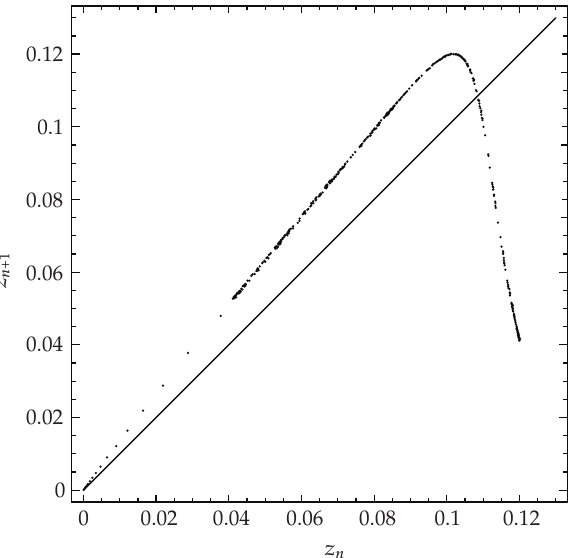
Figure 3: The iterated map for (cid:3) (cid:7) 0 . 4 and δ 2 (cid:7) 0 .